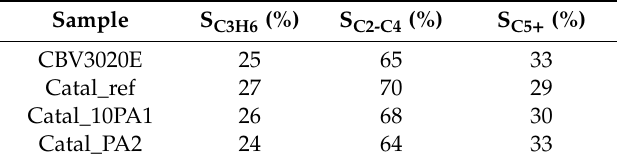
Table 2. Selectivity of the samples in methanol-to-hydrocarbons (MTH) of C 3 H 6 (propylene), C 2 -C 4 (olefins with two to four carbons) and C 5 + (hydrocarbons with more than five carbons including aromatics).